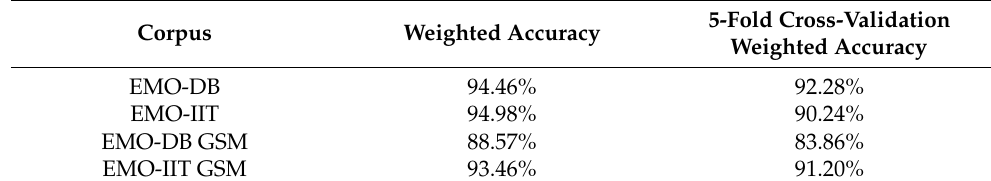
Table 7. Results for speech emotion recognition experiments.